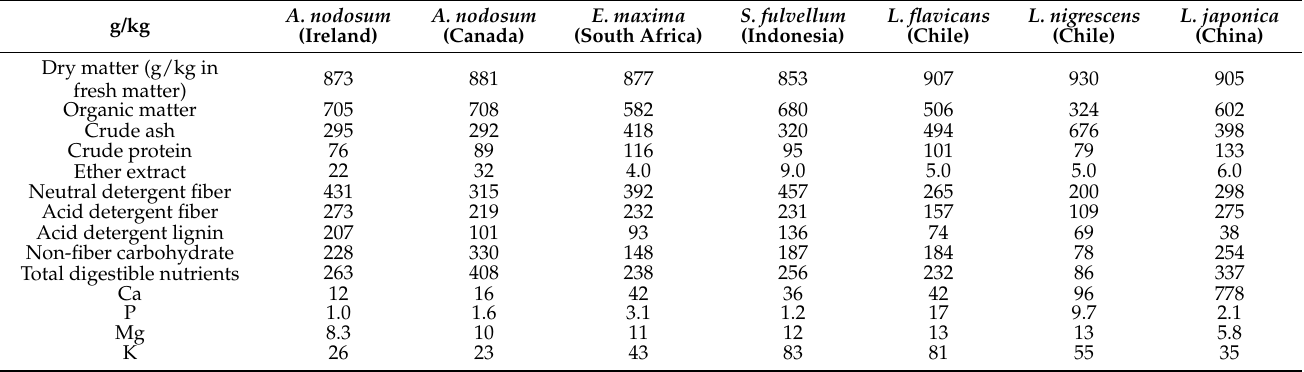
Table 3. Chemical composition (g/kg in dry matter) of the brown seaweeds used for 24 h in vitro incubation.